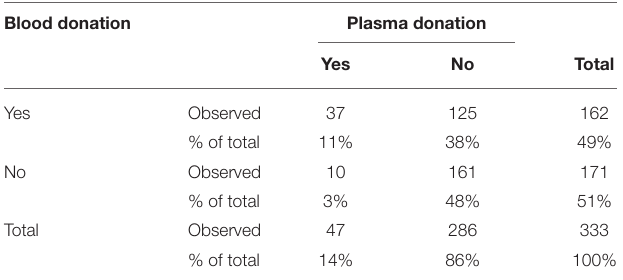
TABLE 2 | Contingency table of participants according to their previous experience with blood and plasma donation. Blood donation